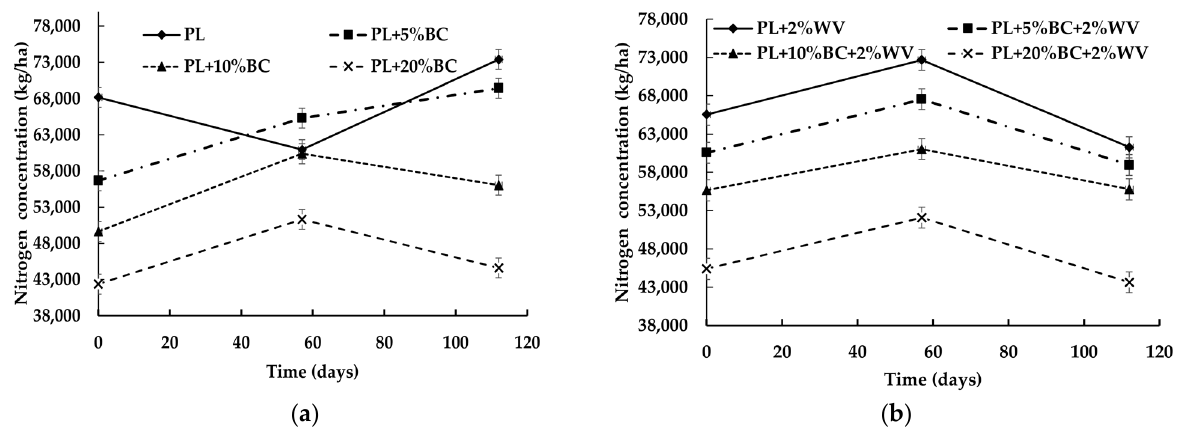
Figure 4. Nitrogen concentration (kg/ha) for poultry litter blends without WV ( a ) and with WV ( b ) over time. After Day 57, PL and PL + 5% BC significantly increased in N. Treatments containing 10% and 20% BC (with and without WV) lost a significant amount of N between Day 57 and Day 112; however, none of these treatments experienced a significant N loss at the end of the study. This indicates that 10% and 20% BC inclusions rates may have helped retain N. Furthermore, at Day 112, PL + 10% BC showed significantly higher N levels compared to Day 0. PL, PL + 5% BC, and PL + 10% BC had significantly higher N concentrations at Day 112 compared to the beginning of the study, with the control having the highest N concentration. Overall, N concentration significantly decreased as BC level increased.